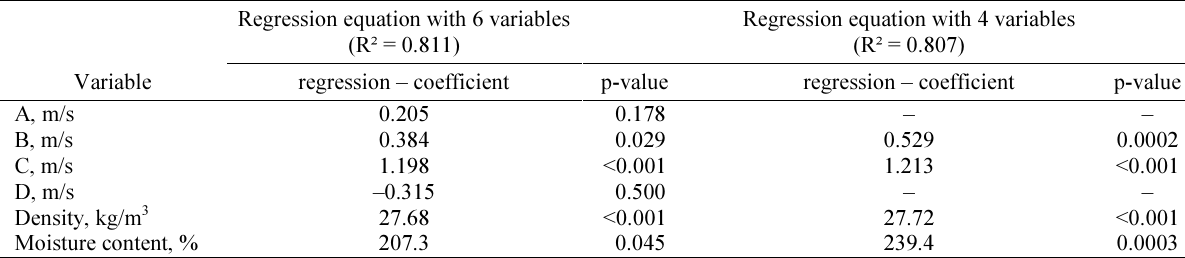
Fig. 5. Relation between modulus of elasticity and C (longitudi- nal direct measurement between the end surfaces in the longitu- dinal direction) Table 4. Predicting modulus of elasticity (y) with multiple variables (x)